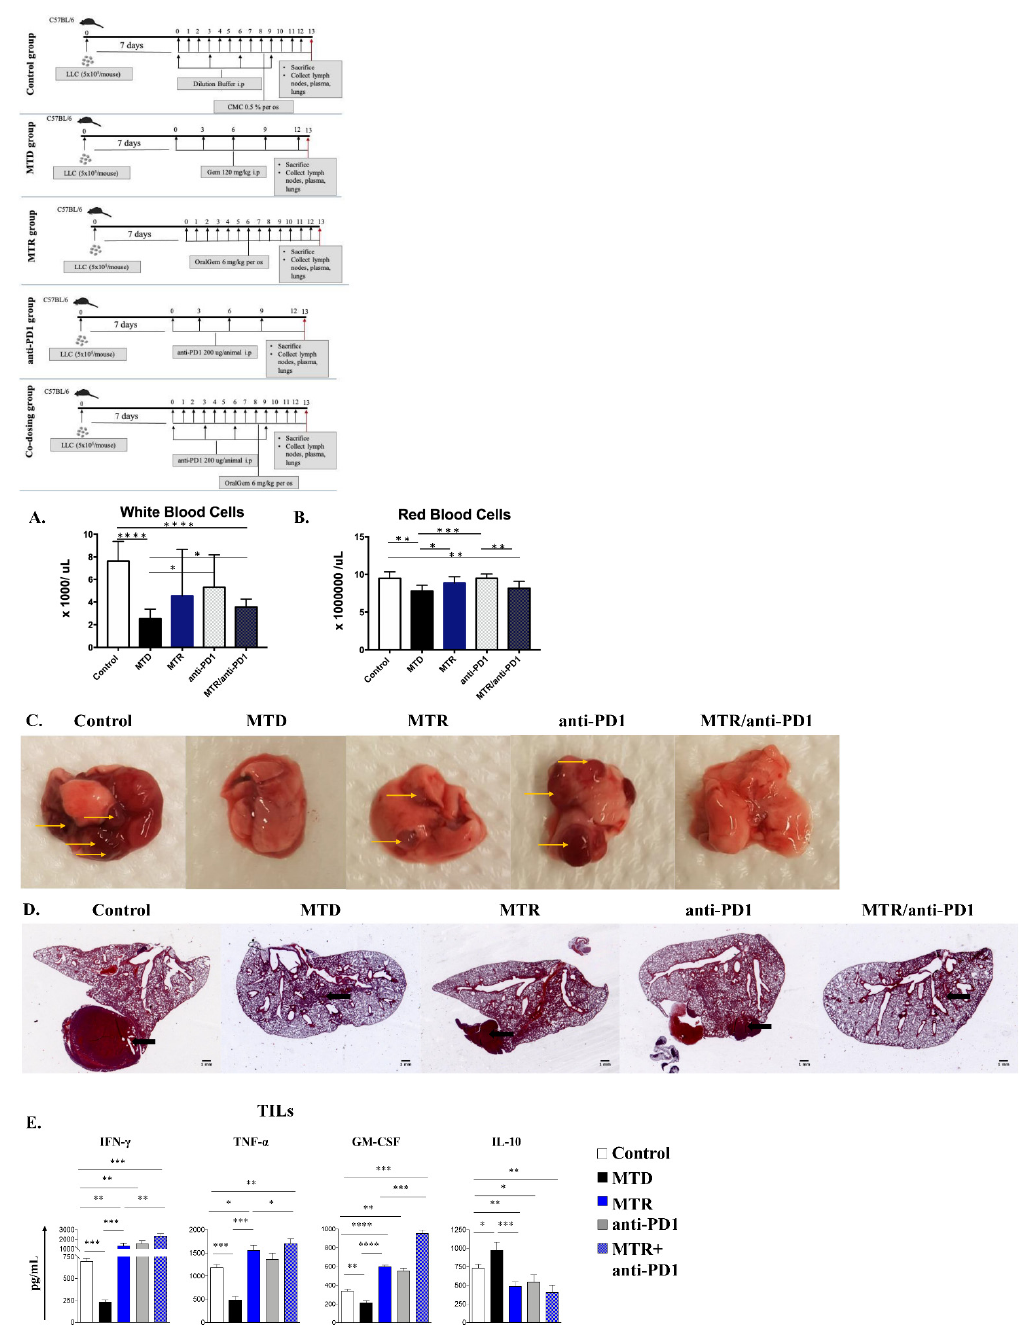
Figure 7. Evaluation of efficacy, toxicity and immune stimulation upon co-administration of OralGem with anti-PD1. ( A , B ) Whole blood was collected for analysis of WBCs and ( B ) RBCs. ( C , D ) Lungs bearing LLC-OVA tumors resected from control ( n = 8), MTD ( n = 7), MTR ( n = 8), anti-PD1 ( n = 8), MTR/anti-PD1-treated mice ( n = 8) are shown (set of experiments = 1). Lungs were observed macroscopically ( C ), whereas the big lung lobe was studied stereoscopically ( D ) (1x magnification), following H&E staining. ( E ) IFN- γ , TNF- α , GM-CSF, and IL-10 levels in cell culture supernatants of TILs stimulated ex vivo with Ova are shown. Data are mean ± SD of triplicate wells from one independent experiment. Statistical analysis was performed by Student’s t -test; * p < 0.05, ** p < 0.01, *** p < 0.001 and **** p <